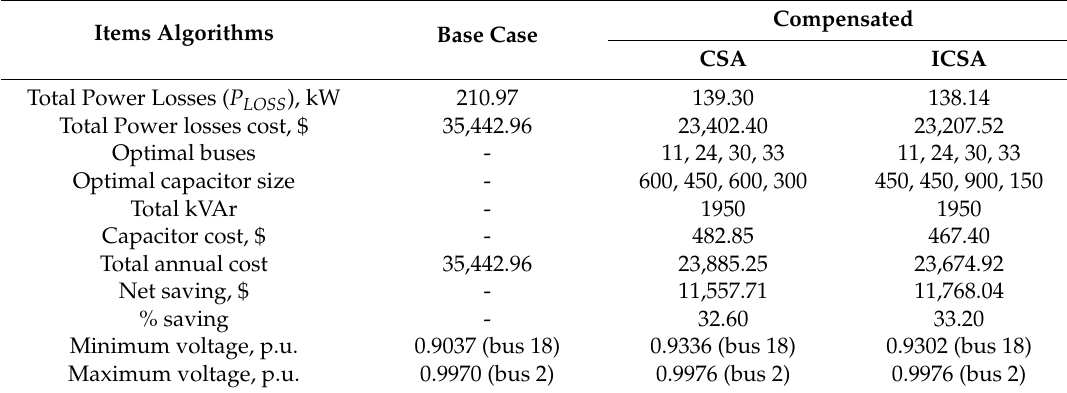
Table 13. Experiment result of ICSA over CSA in 33-bus system.